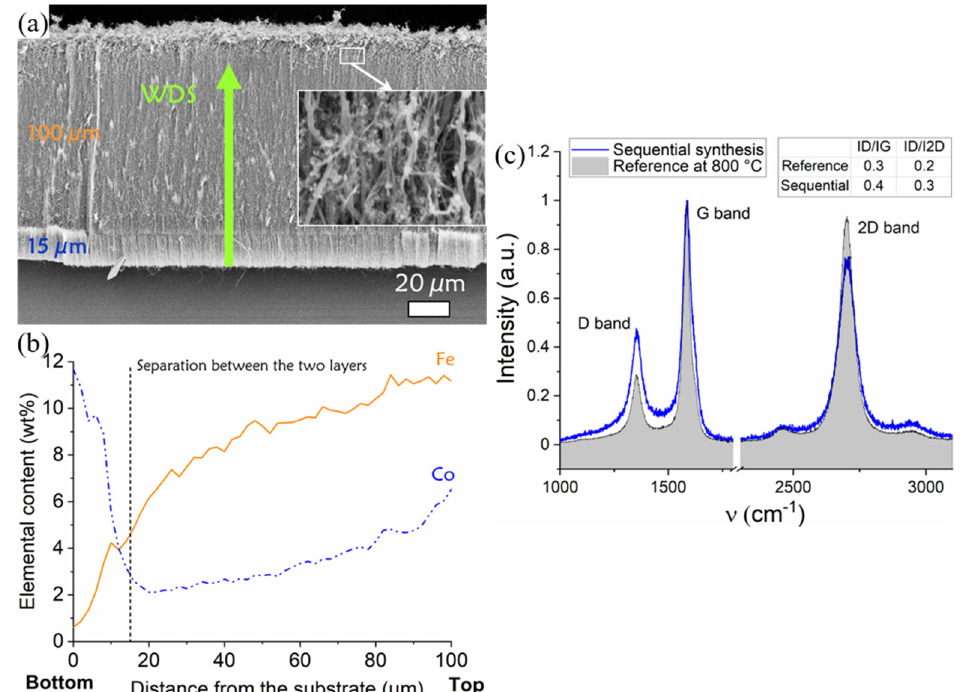
Figure 4. ( a ) SEM image of the bilayer carpet obtained sequentially from ferrocene and cobaltocene metallic precursors. ( b ) WDS elementary profile of iron and cobalt (wt%) performed along the cross-section of the CNT carpet from the substrate. The vertical dashed line indicates the transition zone between the two VACNT layers defined by SEM observations. ( c ) Raman spectra measured on the bilayer carpet compared to a reference sample synthetized with FeCp2 at 800 ◦